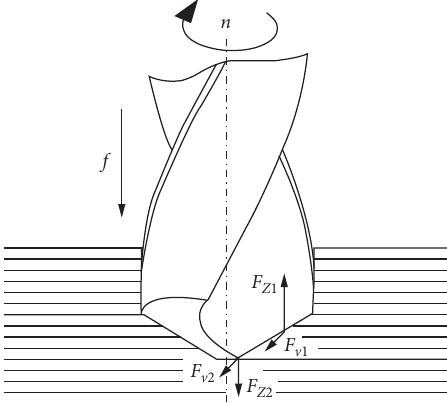
Figure 1: Schematic of drill